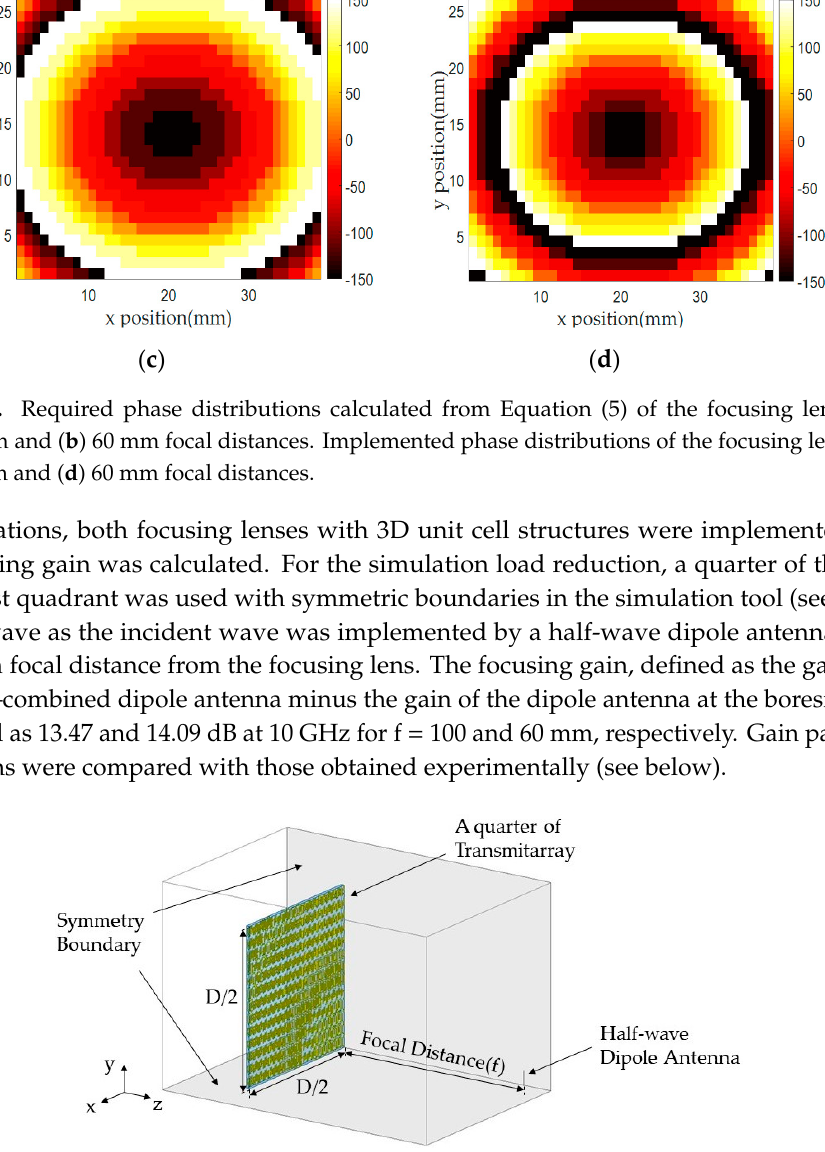
Figure 12. Simulation setup for the focusing lens with a half-wave dipole antenna as a feeding source in symmetry boundaries.